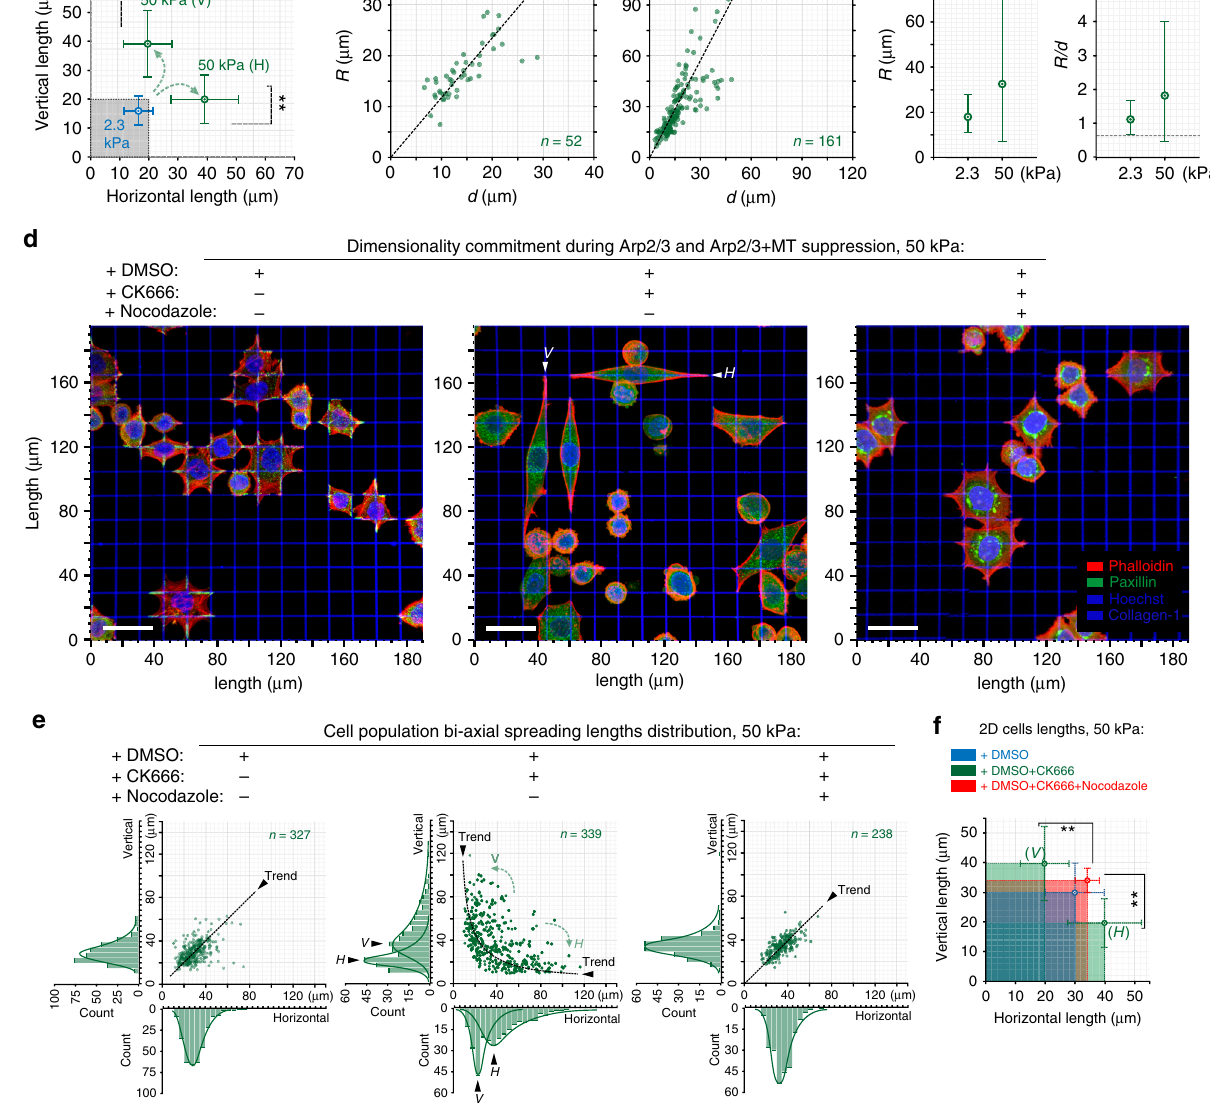
Fig. 5 Arp2/3 suppression promotes a microtubule-dependent uniaxial guidance response. a MDA-MB-468 breast carcinoma cells under Arp2/3 complex inhibition ( + CK666) sense soft (2.3 kPa) and stiff (50 kPa, Supplementary Movie 12) biaxial collagen guidance cues. Note that cell populations on stiff substrates split into vertical and horizontal cell subpopulations (V vertical cells, H horizontal cells). b Morpho-mechanical analysis of cells populations under Arp2/3 inhibition conditions on soft and stiff biaxial cues: free cell edge curvature radii, R . c Average values of R and R / d in cell under Arp2/3 complex inhibition, showing increased traction on stiffer substrates (see Fig. 2g for comparison). The corresponding n values are shown on b . d , e 3D reconstruction overviews and morphometric analysis of the Arp2/3-inhibited cell population response to biaxial guidance cues. Inactivation of Arp2/3 ( + CK666) induces non-equidirectional cell protrusion with random cell commitment to either of the two orthogonal directions (i.e., a uniaxial response). Disruption of intact microtubules in cells with suppressed Arp2/3 complex ( + CK666 + nocodazole) rescues biaxial cell spreading. f Average values of cell lengths from protrusion for each of the conditions in d , e (see color code). The corresponding n values are shown on e . Scale bars — 30 µ m. All corresponding n values are shown on the plots. Number of replicates (independent experiments) for all measurements N = 4. Data in a , c , f are mean ± s.d.; ns: no signi fi cant difference between groups; * p < 0.05, ** p < 0.001 ( c : unpaired t test; a , f :